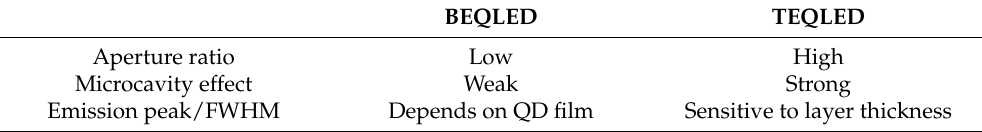
Table 1. Comparison of devices with the BEQLED and TEQLED